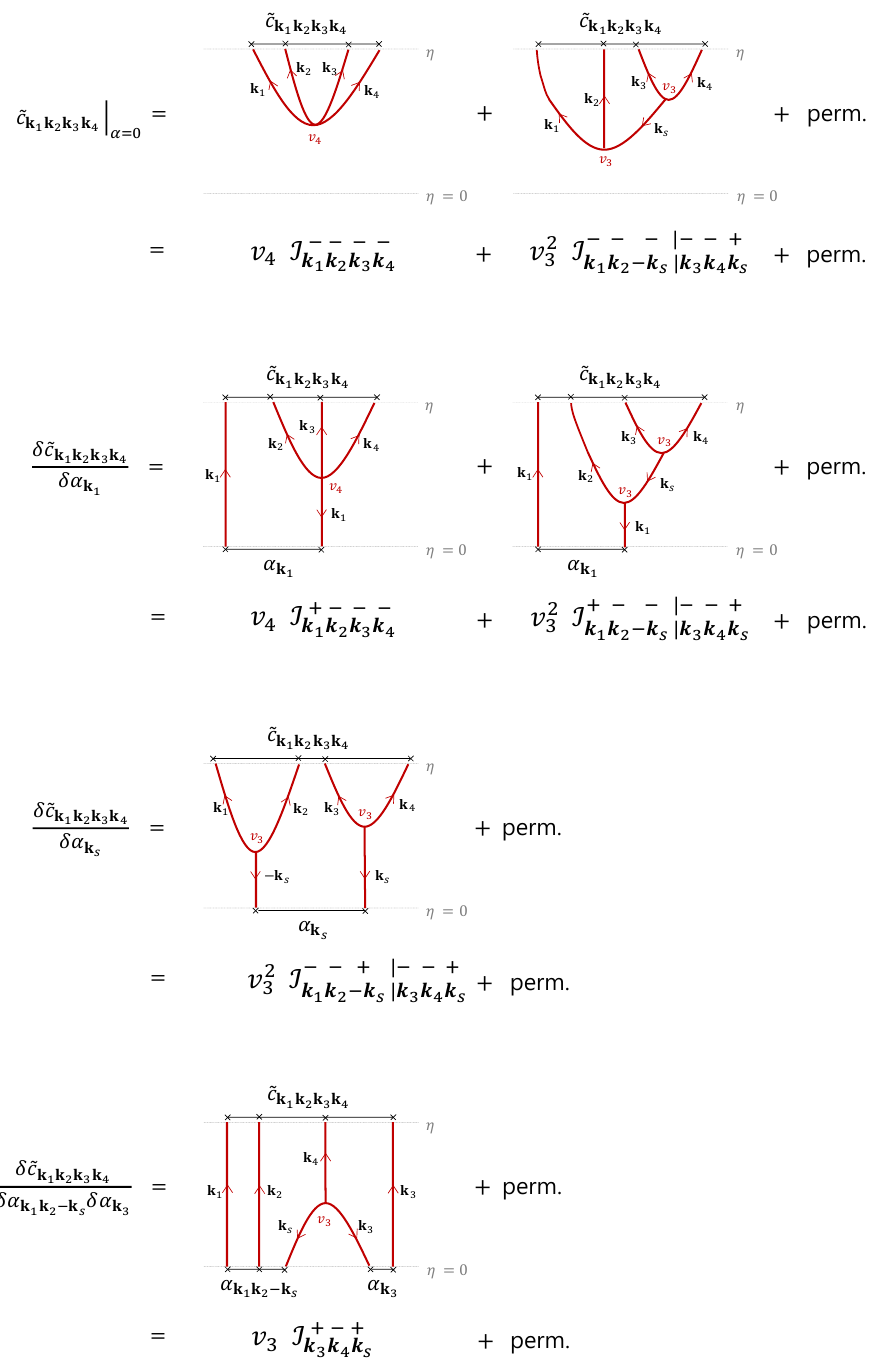
Figure 4 . Diagrammatic representation of the wavefunction coefficient ˜ c k dence on the boundary wavefunction coefficients α k